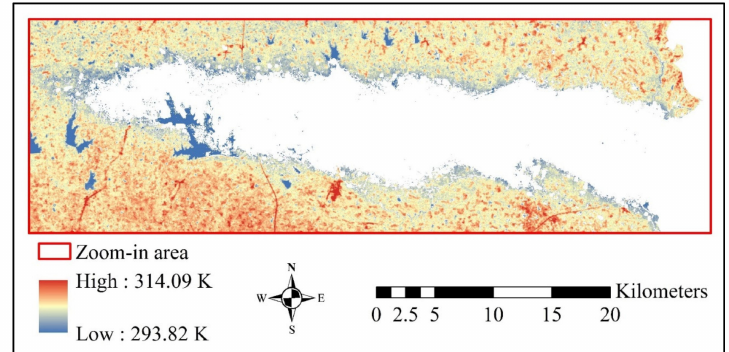
Figure 18. A zoom-in area of the estimated LST where is masked by the QA